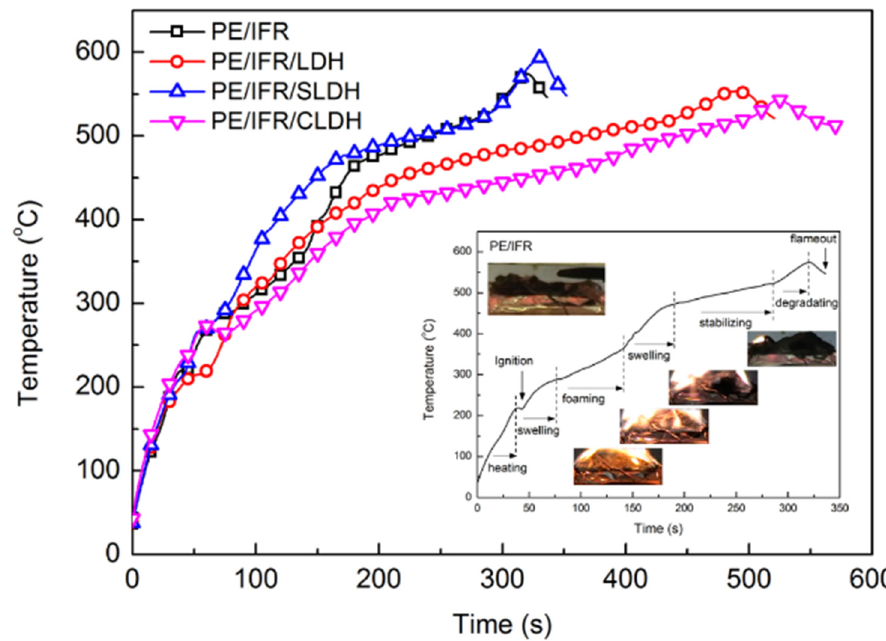
Figure 4. The results of CONE, ( a ) HRR curves, ( b ) THR curves, ( c ) SPR curves, and ( d ) TSR curves.